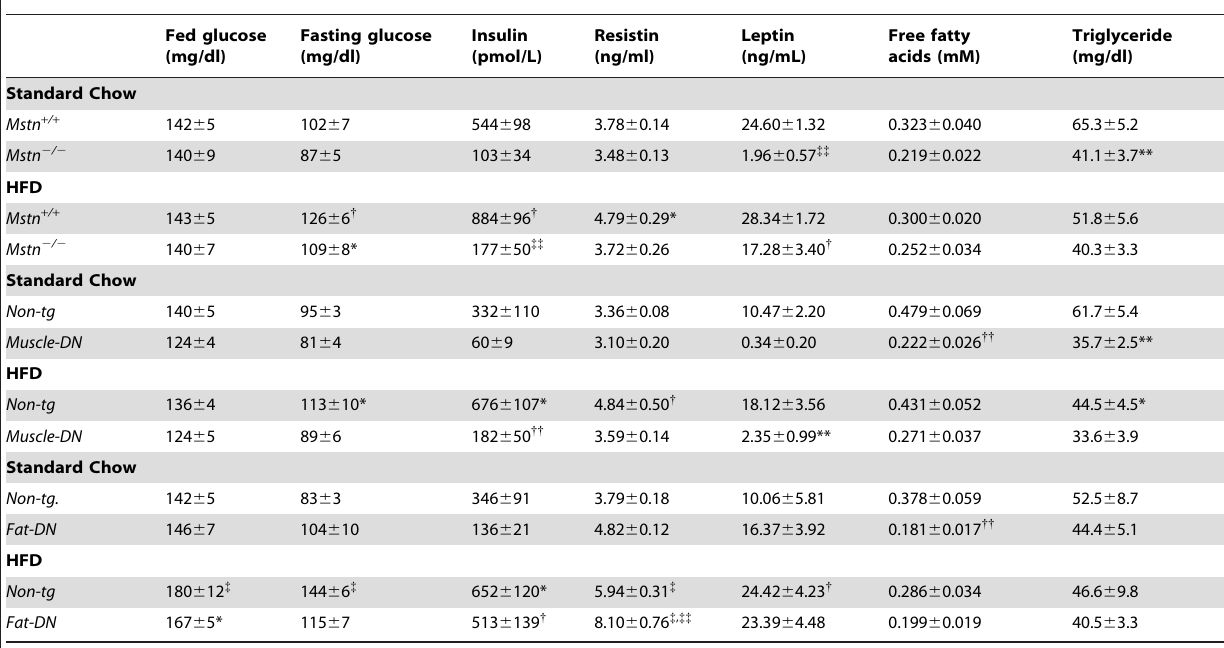
Table 1. Serum chemistry from mice on standard chow and